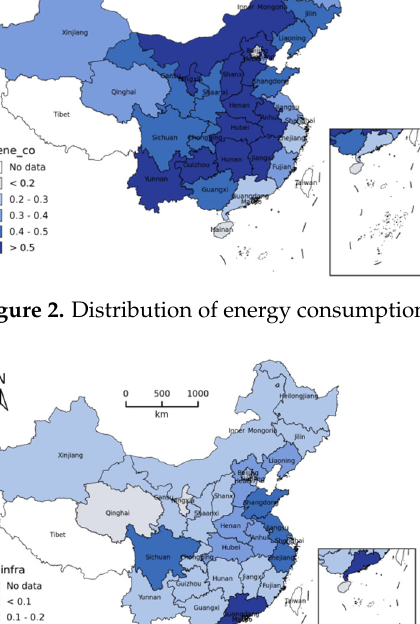
Table 4. Direct impact of NDI on energy structure transition. (1)